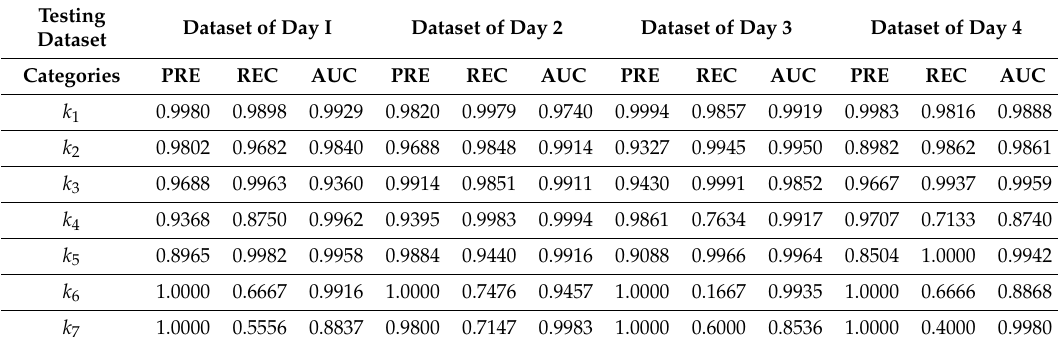
Table 3. The performance test results of our classifier.